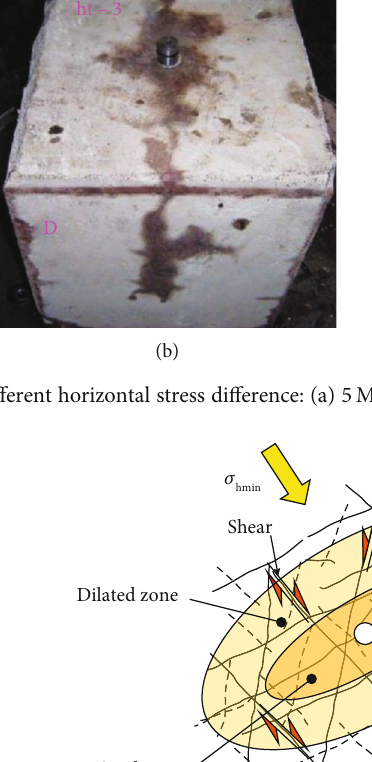
Increase in the fluid viscosity/injection rate